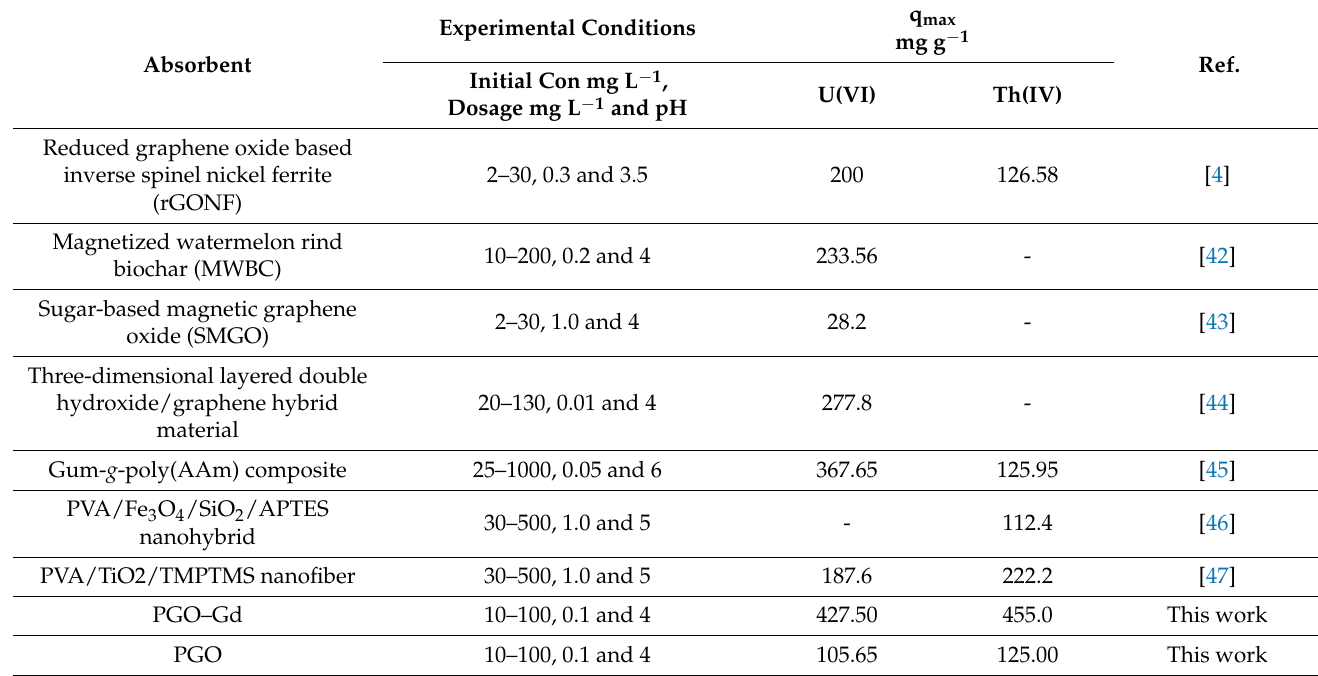
Table 3. Comparison of removal of efficacy of PGO–Gd for U(VI) and Th(IV) using materials reported in the previous literature.